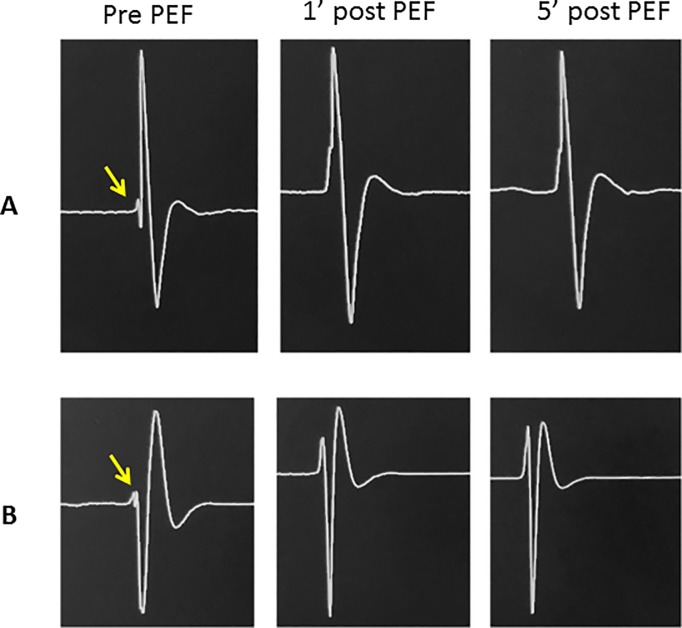
Two examples (A and B) of loss of Purkinje fiber electrical conduction after PEF delivery. Yellow arrow highlights the Purkinje potential.